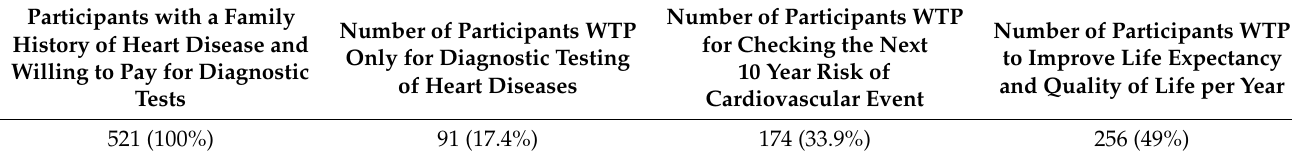
Table 4. Percentage and frequency.